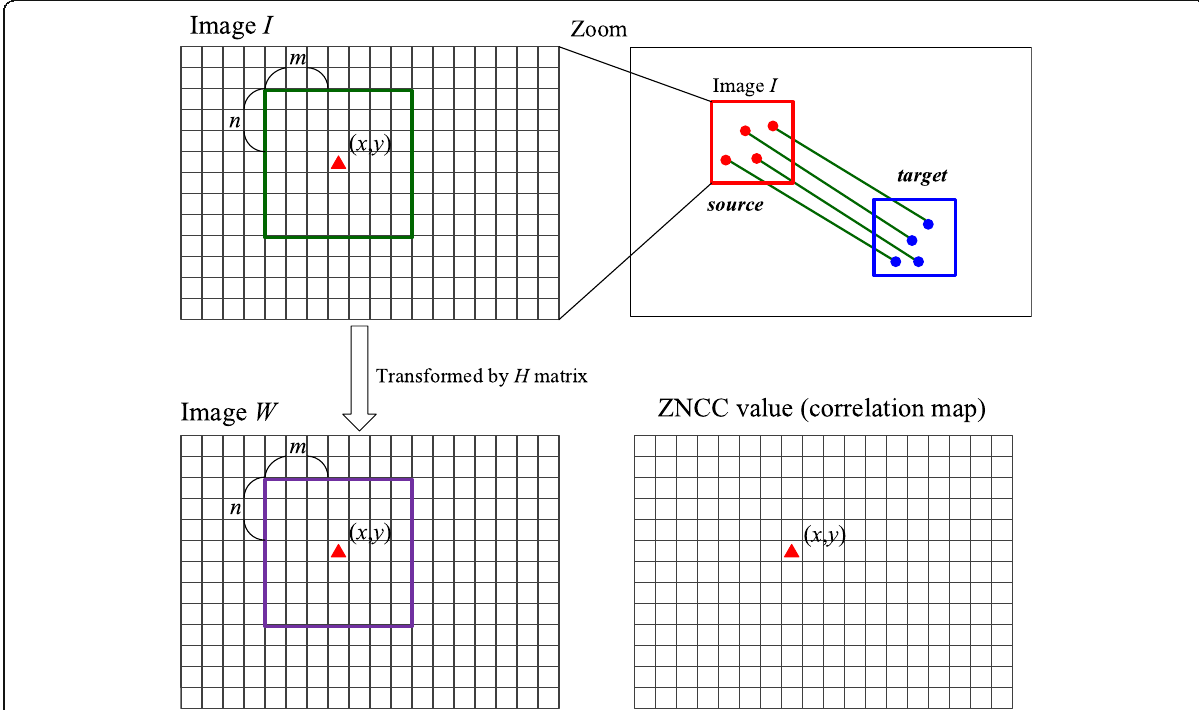
Fig. 6 A profile of transformation from image I to image W by using (1) and ZNCC value labeled as correlation map. ( x , y ) is one of pixels in image I. m and n are set to